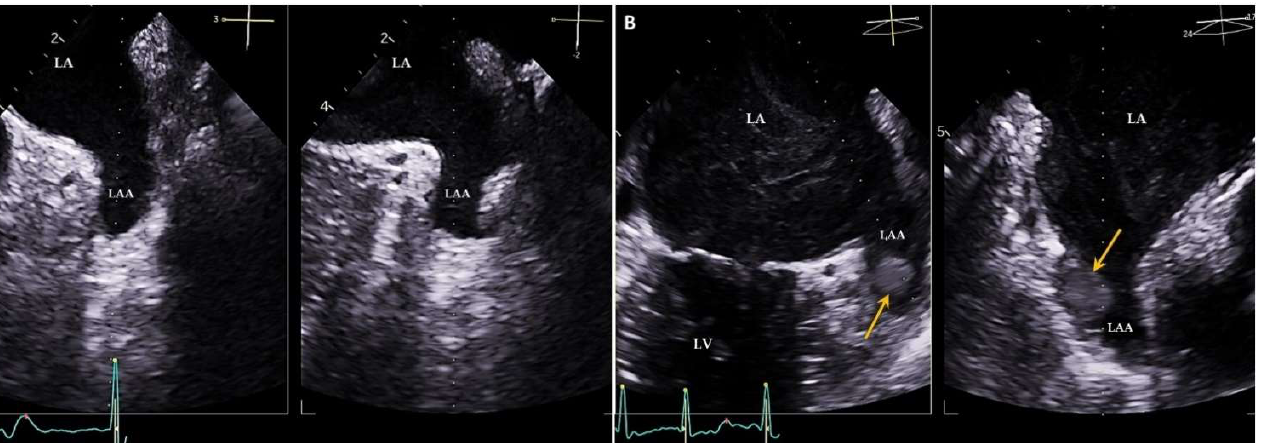
Figure 6. TEE images during invasive procedures in the hemodynamics laboratory. ( A ) 3D TEE image showing crossing of the guidewire (yellow arrow) through the atrial septum. ( B ) 2D TEE image demonstrating the inflated balloon (yellow arrow) through the patent foramen ovale for the sizing of the device to be implanted. ( C ) 2D TEE Midesophageal bicaval plane image depicting the patent foramen ovale closure device (yellow arrow) properly positioned. ( D ) 3D TEE image show- ing correct patent foramen ovale closure device (yellow arrow) placement from the left atrial view. ( E ) 2D TEE Midesophageal aortic valve short axis view illustrating the catheter (yellow arrow) in the LA resting on the left superior pulmonary vein. ( F ) 2D TTE multiplanar image demonstrating the lobe (yellow arrows) deployment of the atrial appendage closure device. ( G ) 2D TTE multipla- nar image showing the implanted atrial appendage closure device (yellow arrows) while traction maneuvers are performed to assess the correct positioning of the device. ( H ) 2D TTE image showing the appendage closure device (yellow arrow) correctly positioned at the end of the procedure. Ao: Aorta; LA: Left atrium; RA: Right atrium; SCV: Superior cava vein. 3.3. CMR CMR allows assessment of LA morphology and functionality, as well as tissue char- acterization of the atrial wall, and is considered the gold standard for non-invasive study of atrial volumes [42,43]. Two-dimensional cine sequences are commonly employed to measure LA diameters and volumes and to evaluate global LA function (ejection fraction). The biplane area– length method (Figure 7), using two-chamber and four-chamber cine sequences, or the